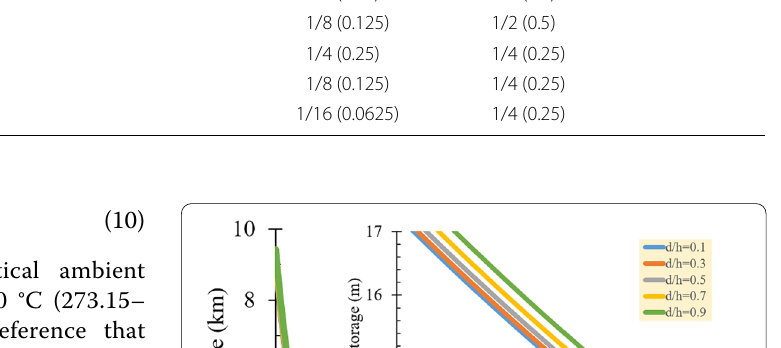
Table 6 Geometric shapes and dimension ratios used in Frank-Kamenetskii model Geometric shape Dimension ratio Geometric shape Dimension ratio Note Cylinder